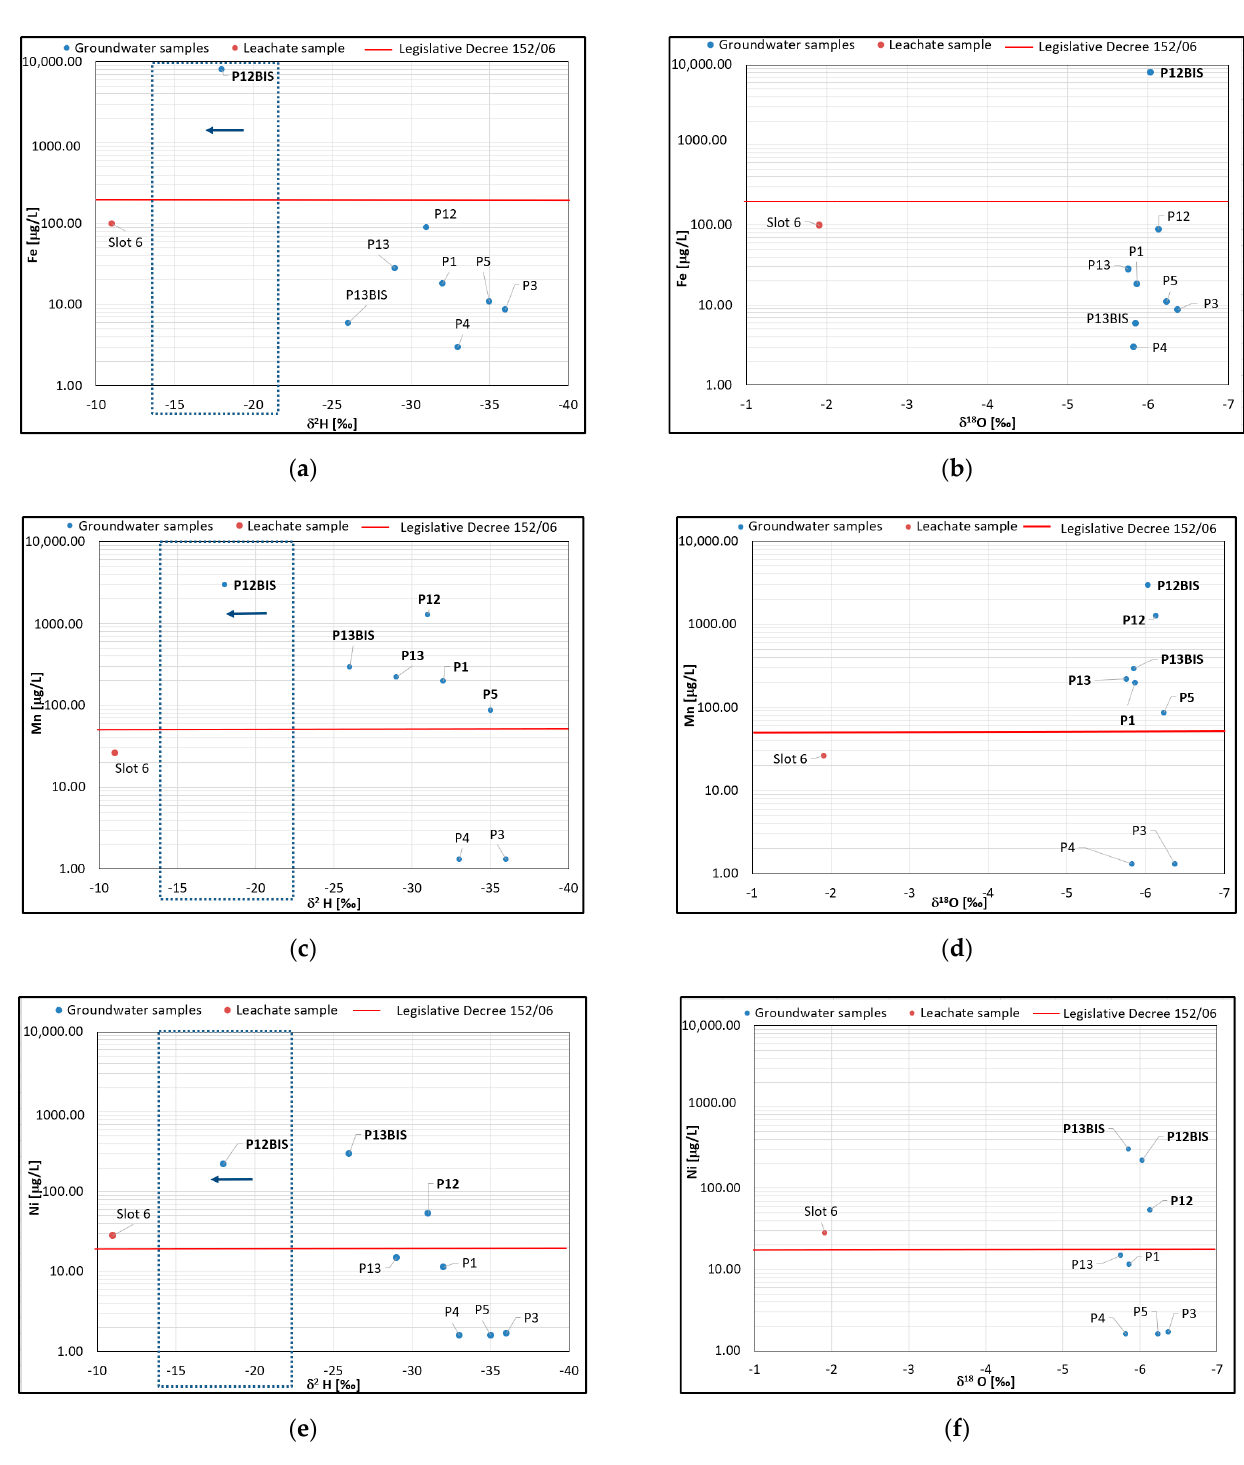
Figure 6. Scatter plot ( a ) Fe and δ 2 H, ( b ) Fe and δ 18 O, ( c ) Mn and δ 2 H, ( d ) Mn and δ 18 O, ( e ) Ni and δ 2 H and ( f ) Ni and δ 18 O.